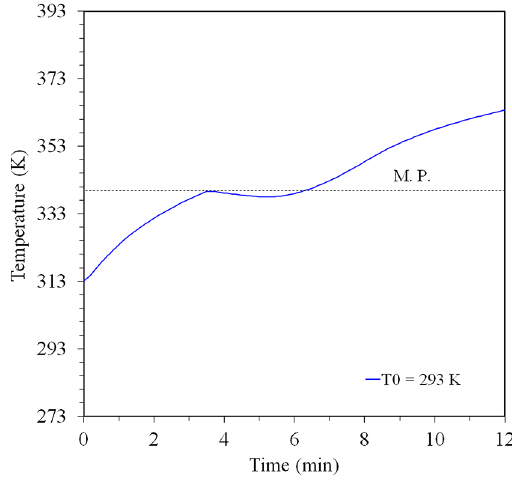
Figure 4. Simulated temperature for the interface region between SA and the sample holder for the front position with onset at 313 K. The dot line represents the melting temperature of the